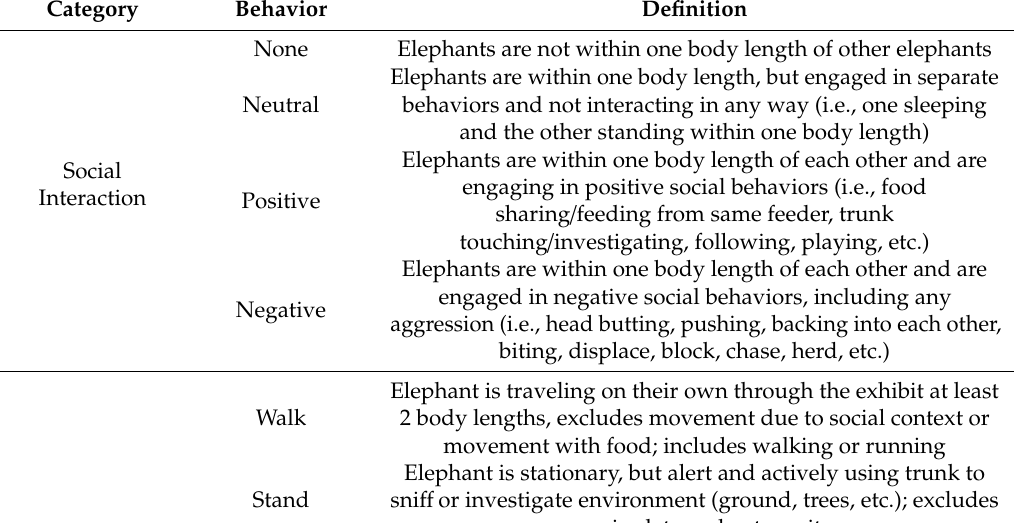
Table 2. Ethogram of behaviors observed between November 2017 and 2019 on one male and six female Asian elephants housed at the Smithsonian National Zoological Park. During data collection, the location of each elephant was also